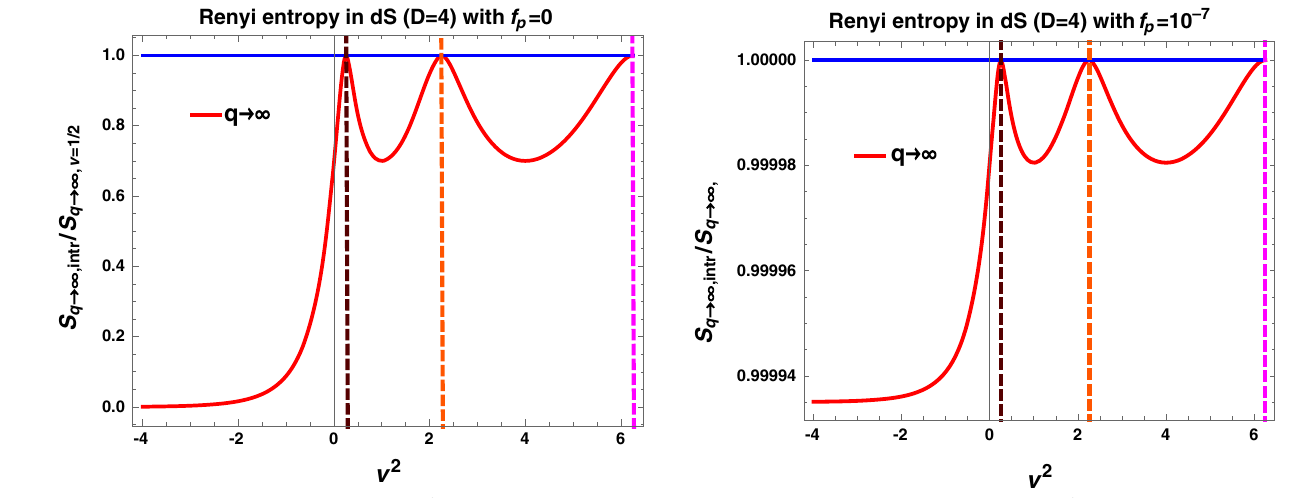
(b) Normalized R´ e nyi entropy vs ν 2 in 3+1 D de Sitter space with axionic source ( f p = 10 − 7 ). eigenvalue of density matrix. Here we set (cid:14) C = 10 , 000. In both cases we have normalised the entanglement entropy with the result obtained from ν = 1 / 2, which is the conformal limit result